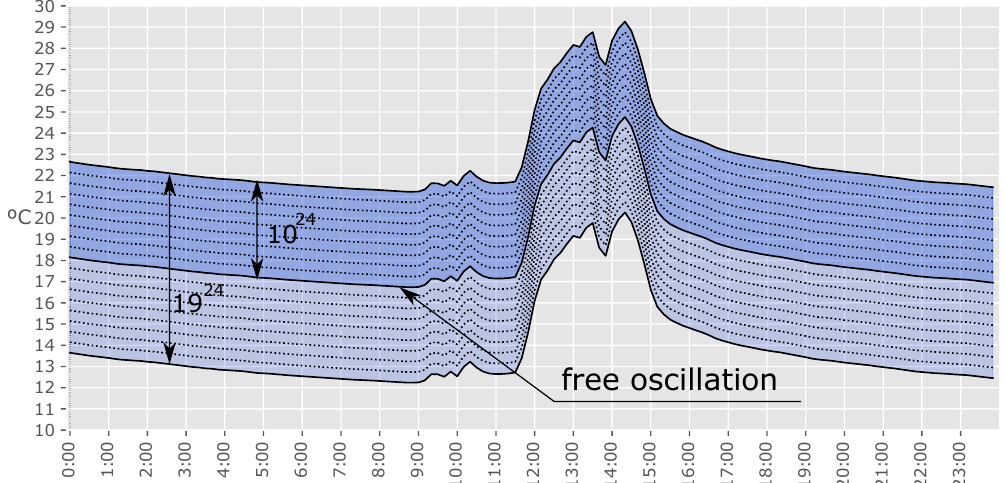
Figure 6. Search space reduction that supposes the consideration of the free oscillation curve in the winter